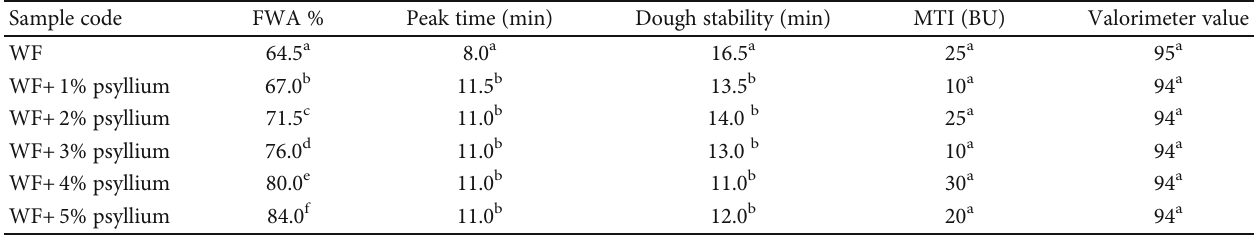
Table 2: Farinograph characteristics of dough made from fl our and psyllium blends.